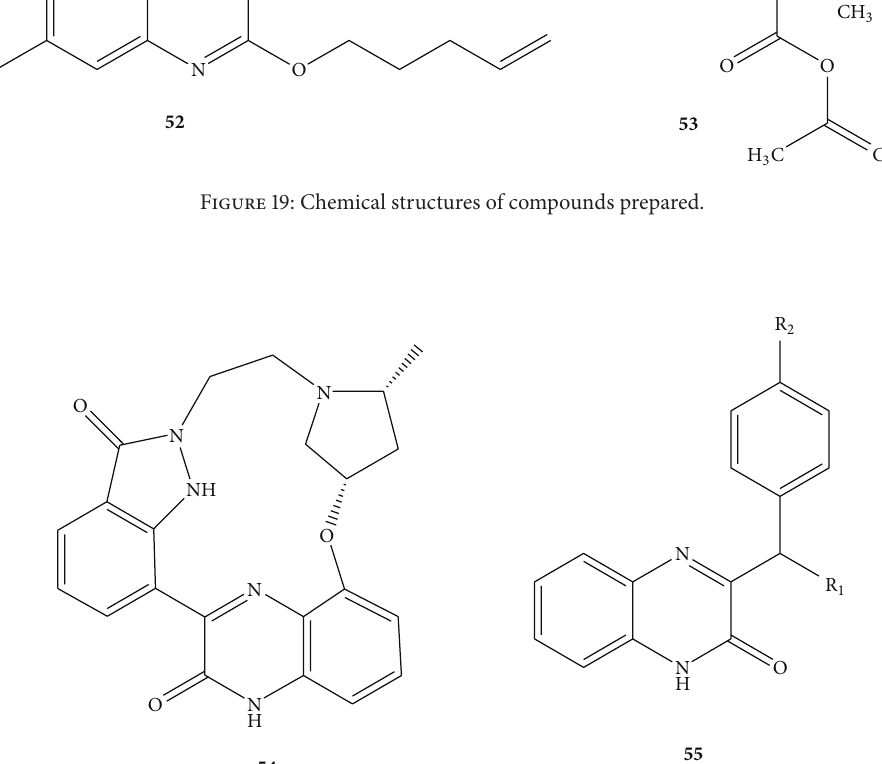
Figure 20: Chemical structures of compounds 54 and 55 .